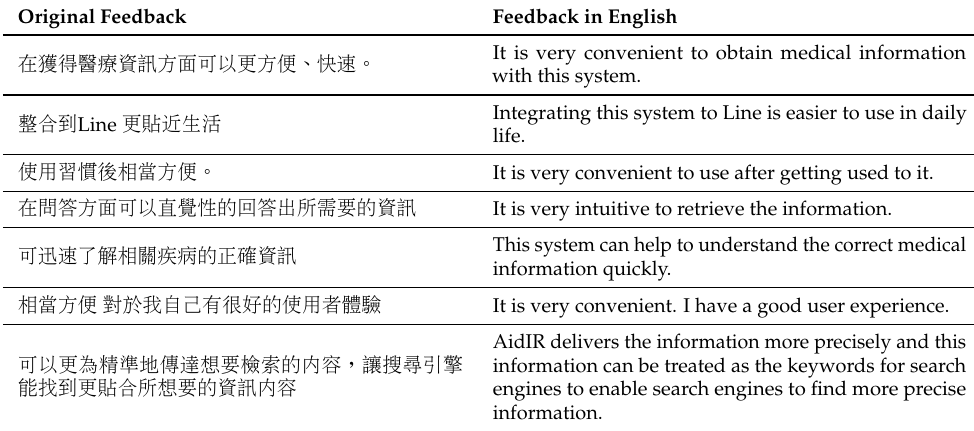
Table 13. Advantages of